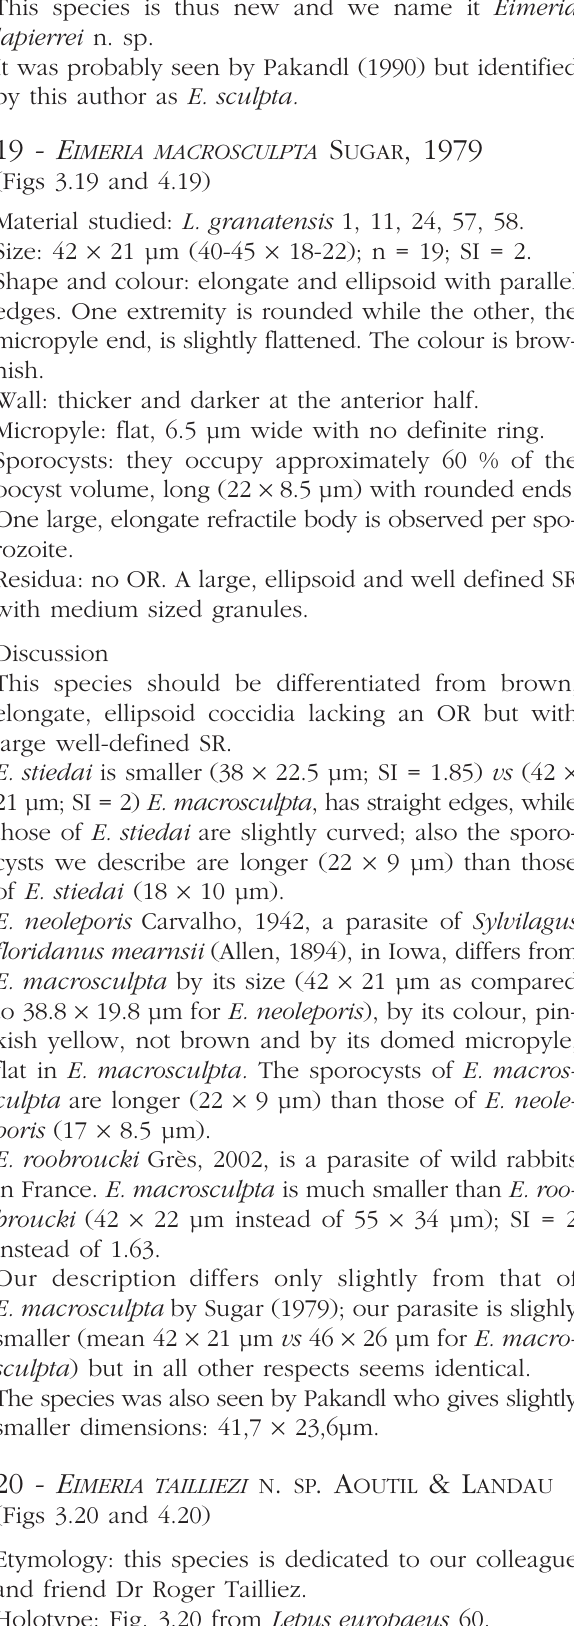
Shape and colour: ovoid, nearly white and tinged with yellow-brown around the micropyle. Wall: smooth and thin. Micropyle: straight, measuring 4.5 µm in diameter, sur- rounded by a ring that appears stuck to the